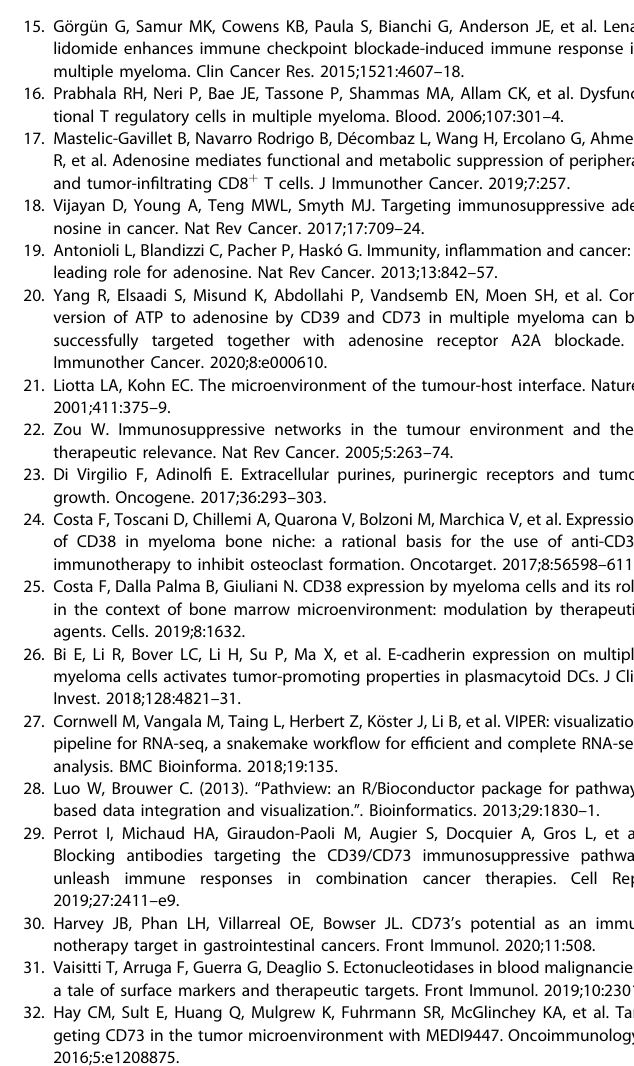
Fig. 7 Schematic representation of the immunosuppressive adenosine-signaling pathway in MM bone marrow microenvironment. Schema shows modulation of immunosuppressive adenosine-signaling pathway via CD73 during pDC-T-NK-MM cells interactions, as well as therapeutic utility of targeting CD73 in